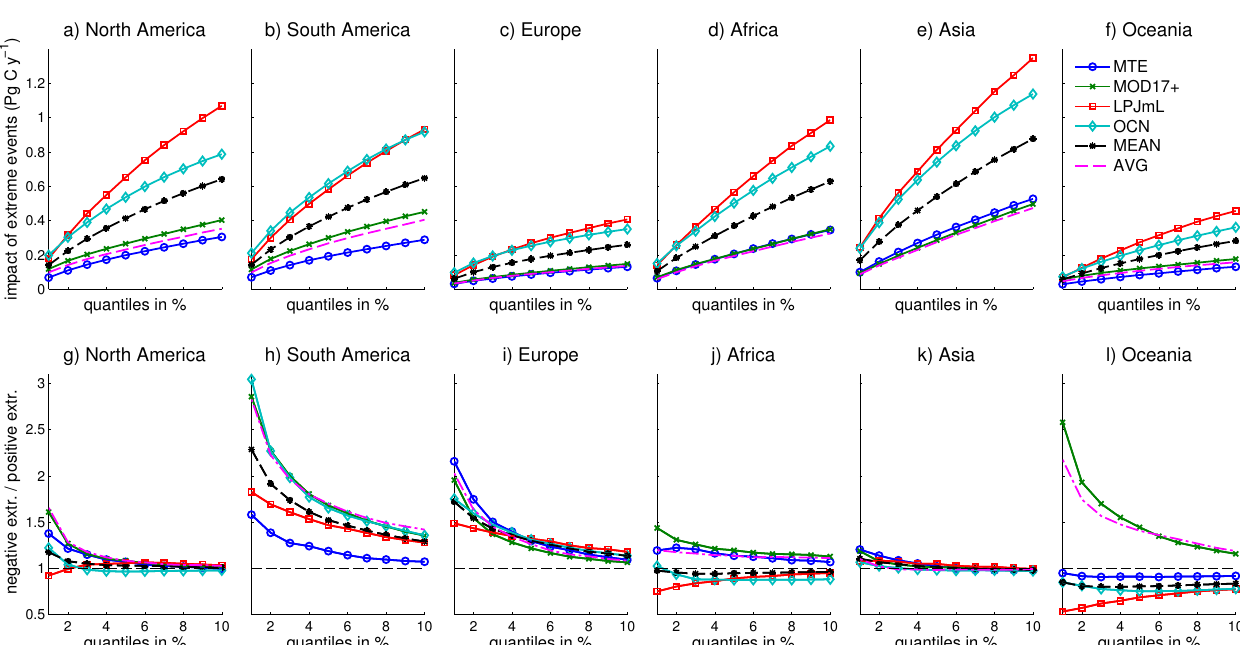
Figure 6. Overall impact and asymmetry of GPP extreme events. Depicted are the four different GPP data sets (MTE, MOD17+, LPJmL, OCN), the average of the results of the four (MEAN), and the results for the averaged data set (AVG). (a–f) Sum of the overall impact of the largest 200 extreme events in GPP for each continent using the percentiles 1 to 10. (g–l) Quotient between 200 largest negative and 200 largest positive extreme events in GPP for each continent using the percentiles 1 to